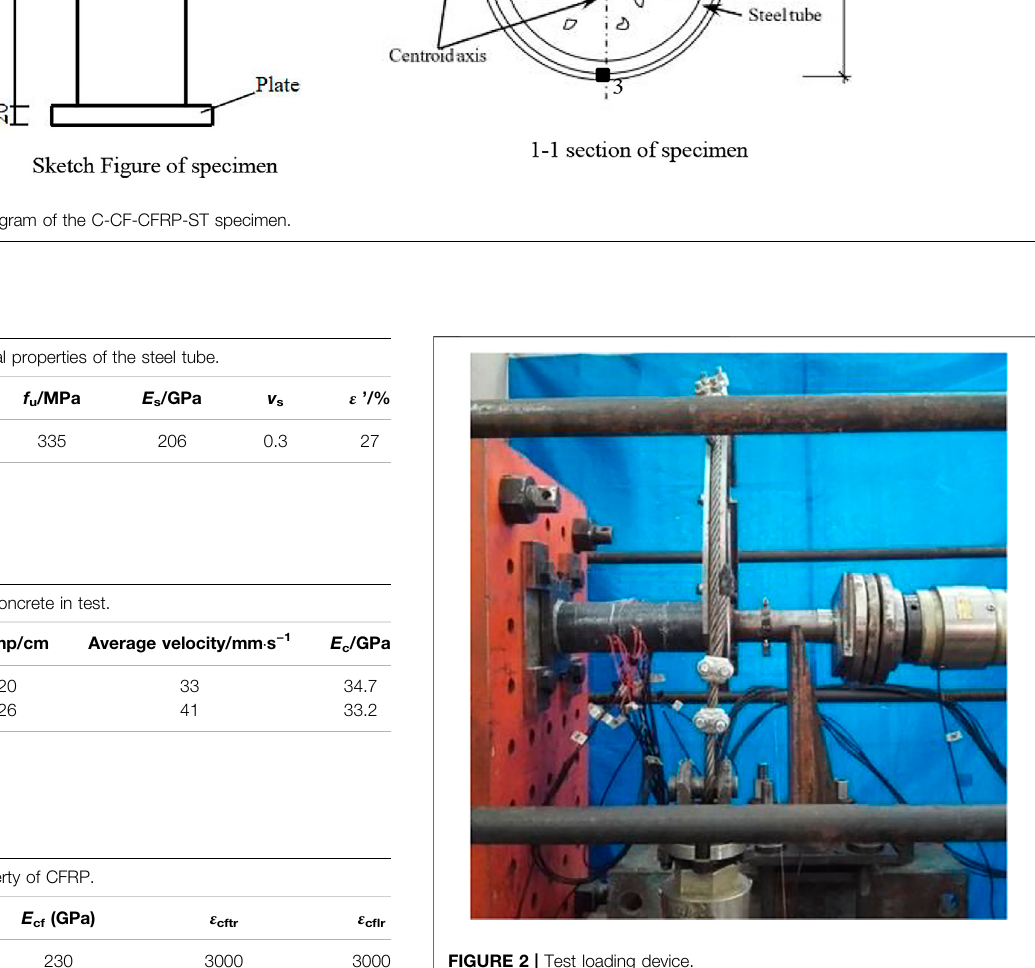
FIGURE 2 | Test loading